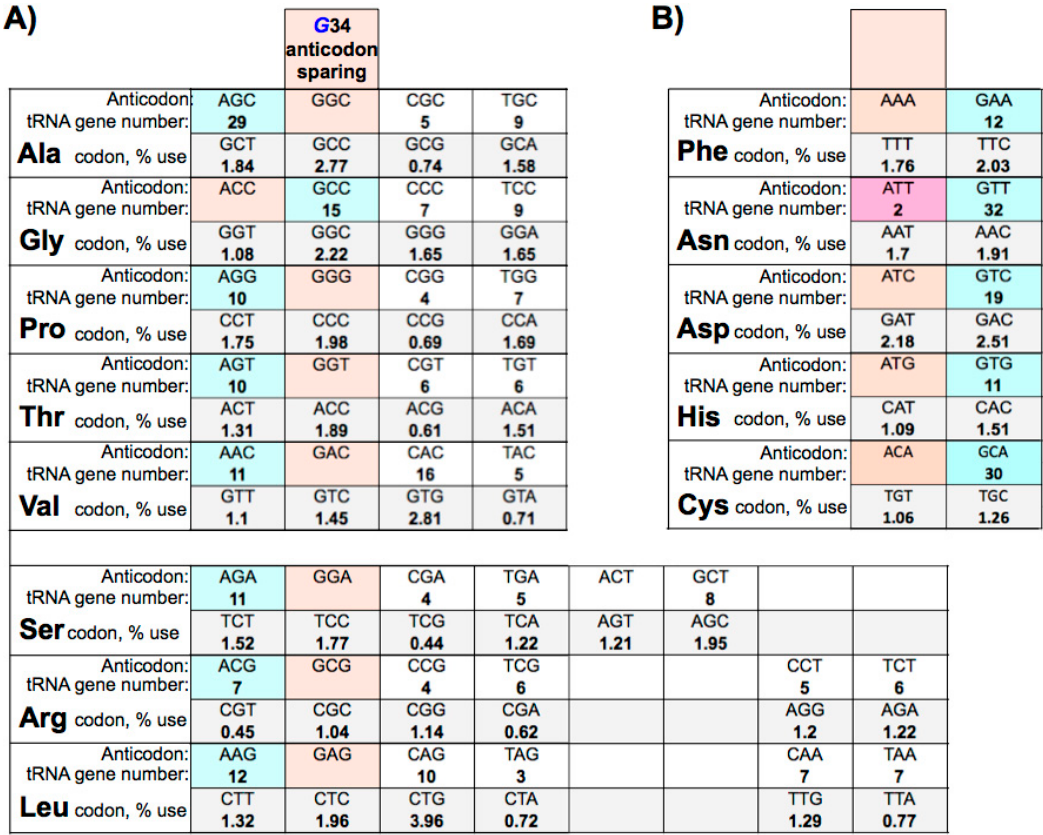
Figure 1. Examples of G34 and A34 anticodon-sparing in the human tRNAome. ( A ) G34 anticodon sparing predominates in the four-box and six-box codon sets. The tRNA gene numbers are listed for each anticodon. Blue shaded rectangles contain numerous tRNA genes for the same A34 anticodon and salmon colored rectangles indicate absence of any tRNA gene encoding a G34 anticodon for the same amino acid. Note that in each case where the A34 anticodon is used its A34 is converted to inosine and the overall codon % use is higher for the wobble codon. Non-colored rectangles show tRNA gene copy numbers for anticodons with C or T at the 34 position; ( B ) A34 anticodon sparing predominates in the two-box codon sets, only some of which are shown here. Blue shaded rectangles contain numerous tRNA genes for the same G34 anticodon and salmon colored rectangles indicate absence of any tRNA gene encoding a A34 anticodon for the same amino acid. The pink colored rectangle reflects a case where two genes with ATT codons exist (see text). More examples of these so-called exceptions to otherwise forbidden anticodon genes are provided in Figure 2. This figure is a partial summary of a tRNAscan-SE analysis of Homo sapiens (hg19 - NCBI Build 37.1 Feb 2009 found online at http://lowelab.ucsc.edu/GtRNAdb/Hsapi19/) .